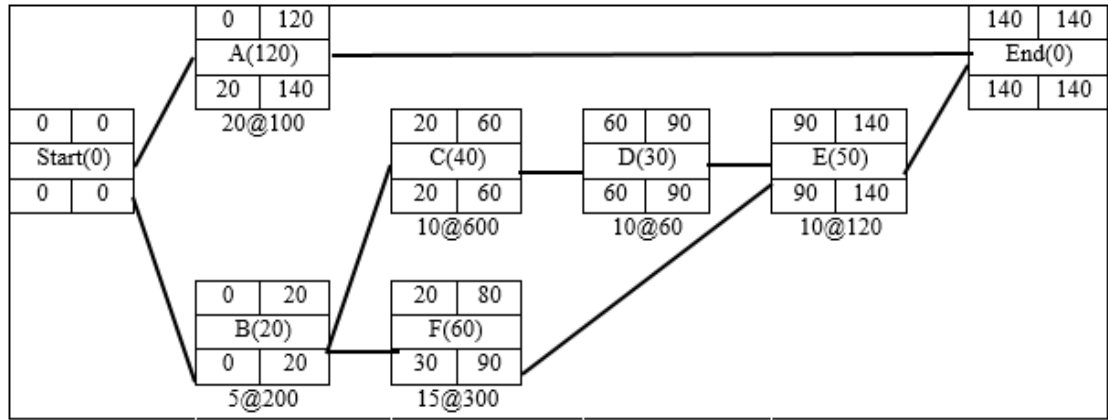
Figure 1. Precedence diagram of all activities.